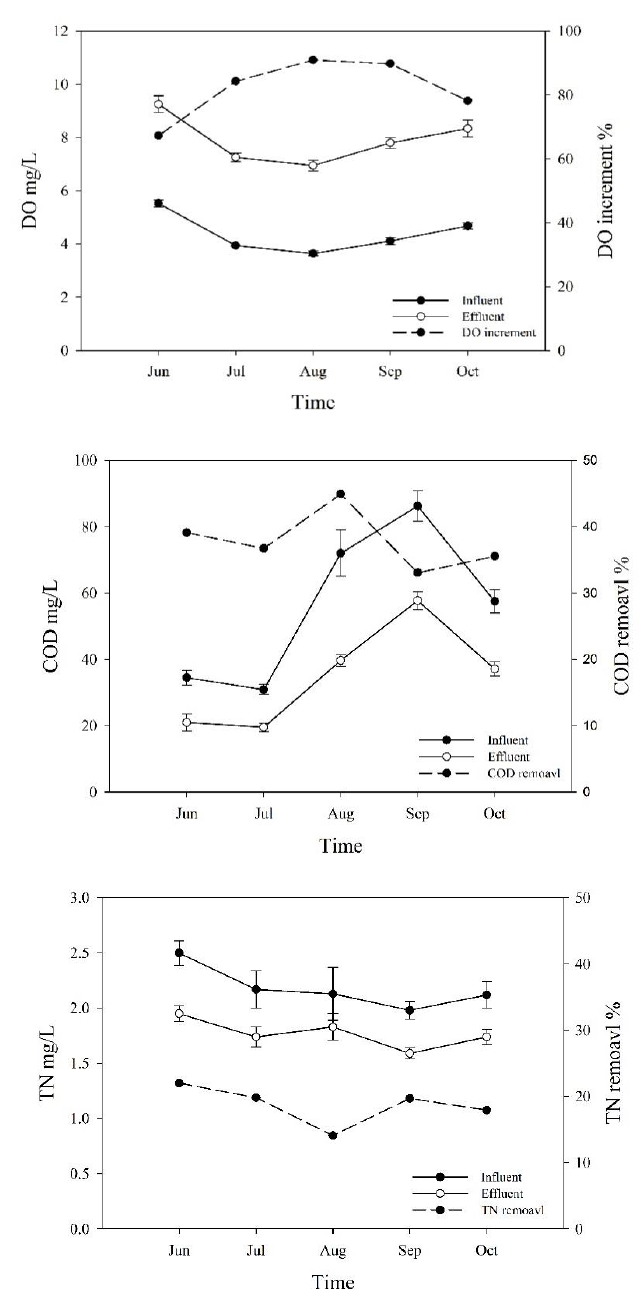
Figure 4. The water quality changes in the water treatment pond.